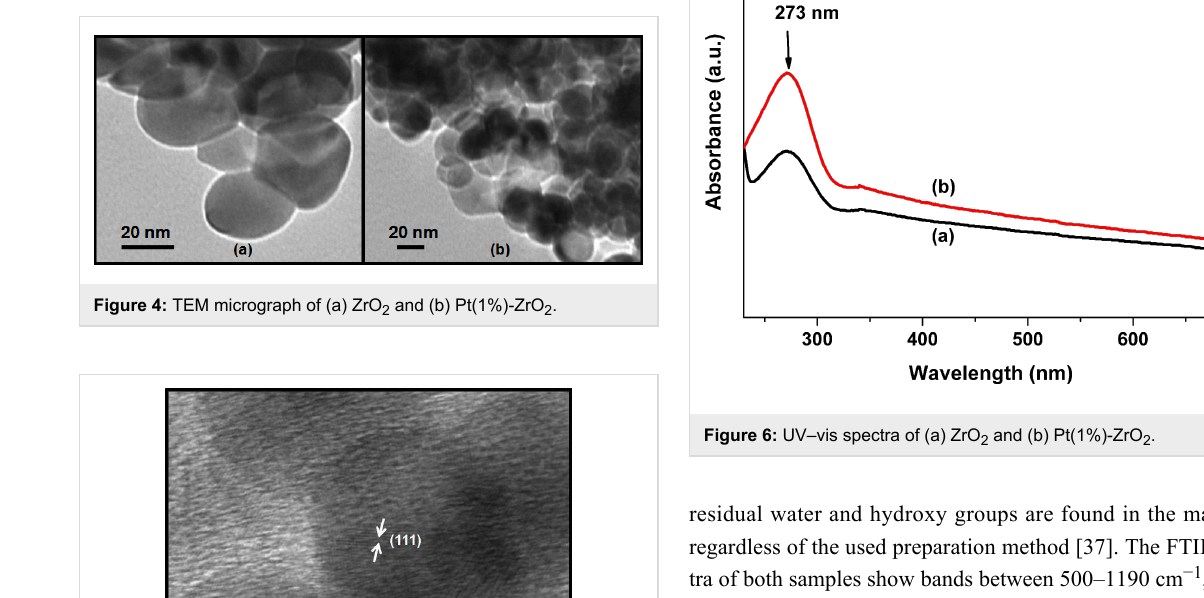
residual water and hydroxy groups are found in the materials regardless of the used preparation method [37]. The FTIR spec- tra of both samples show bands between 500–1190 cm − 1 , which correspond to Zr–O stretching vibrations. Two broad bands at 1380 and 1432 cm − 1 appeared due to the carbonate